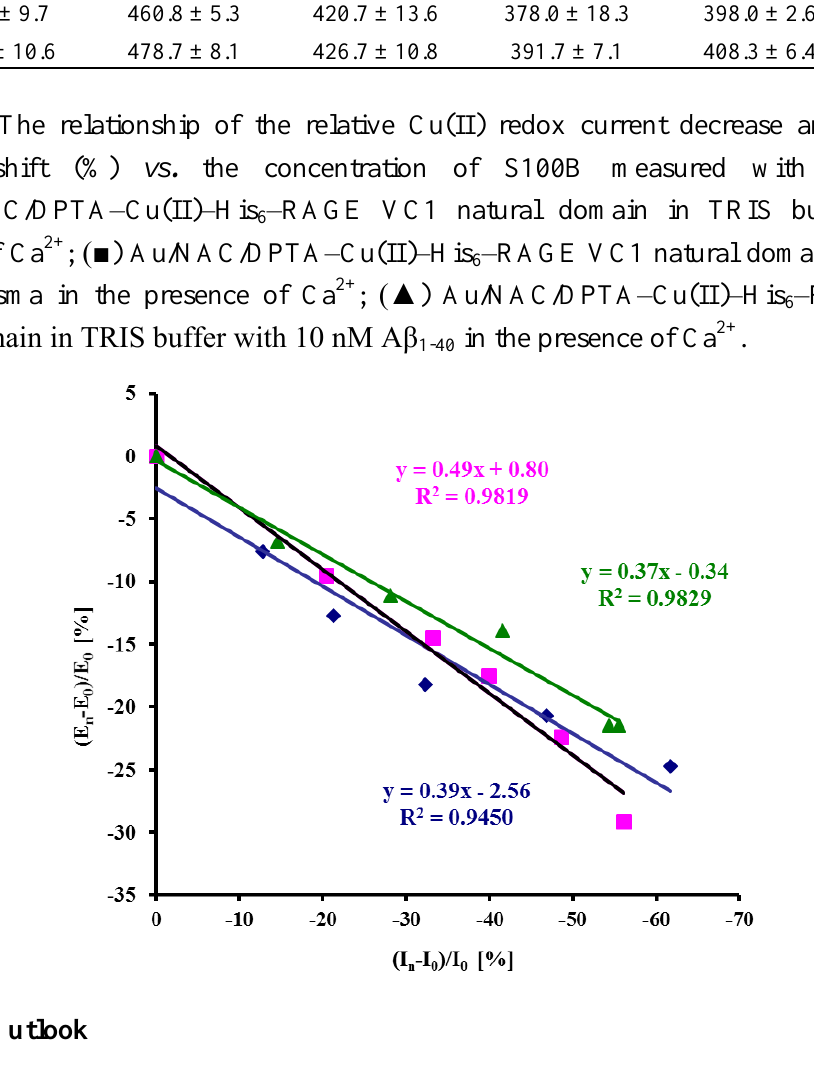
Table 3. The half peak width Δ E His –RAGE C2 and VC1 domains after incubation with S100B solution. 6